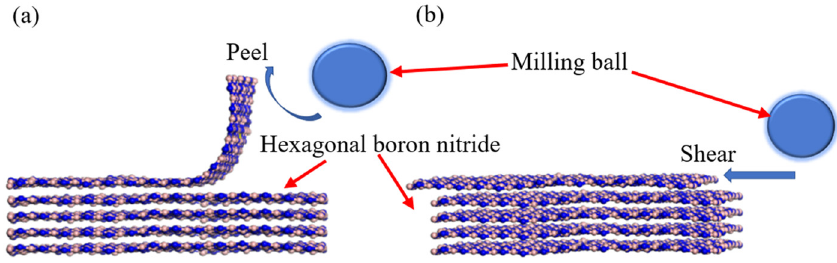
Figure 3: Schematics of exfoliating BNNS from hexagonal boron nitride under ( a ) peel force and ( b ) shear force created by the metallic balls in the rotating shell.